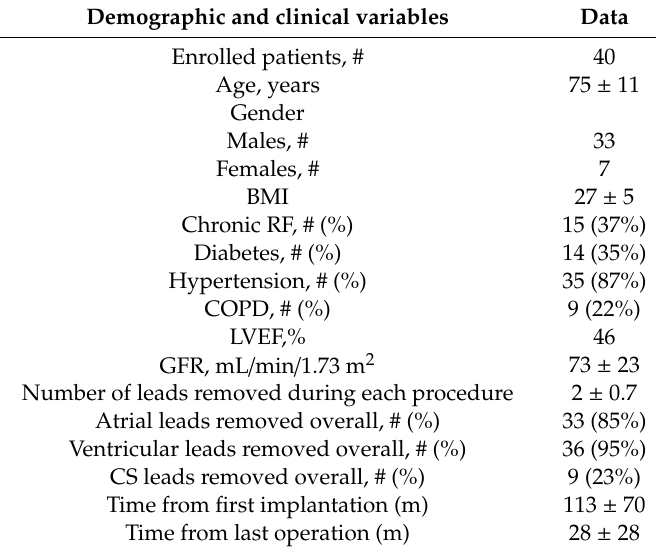
Table 1. Demographic and clinical data. Demographic and clinical